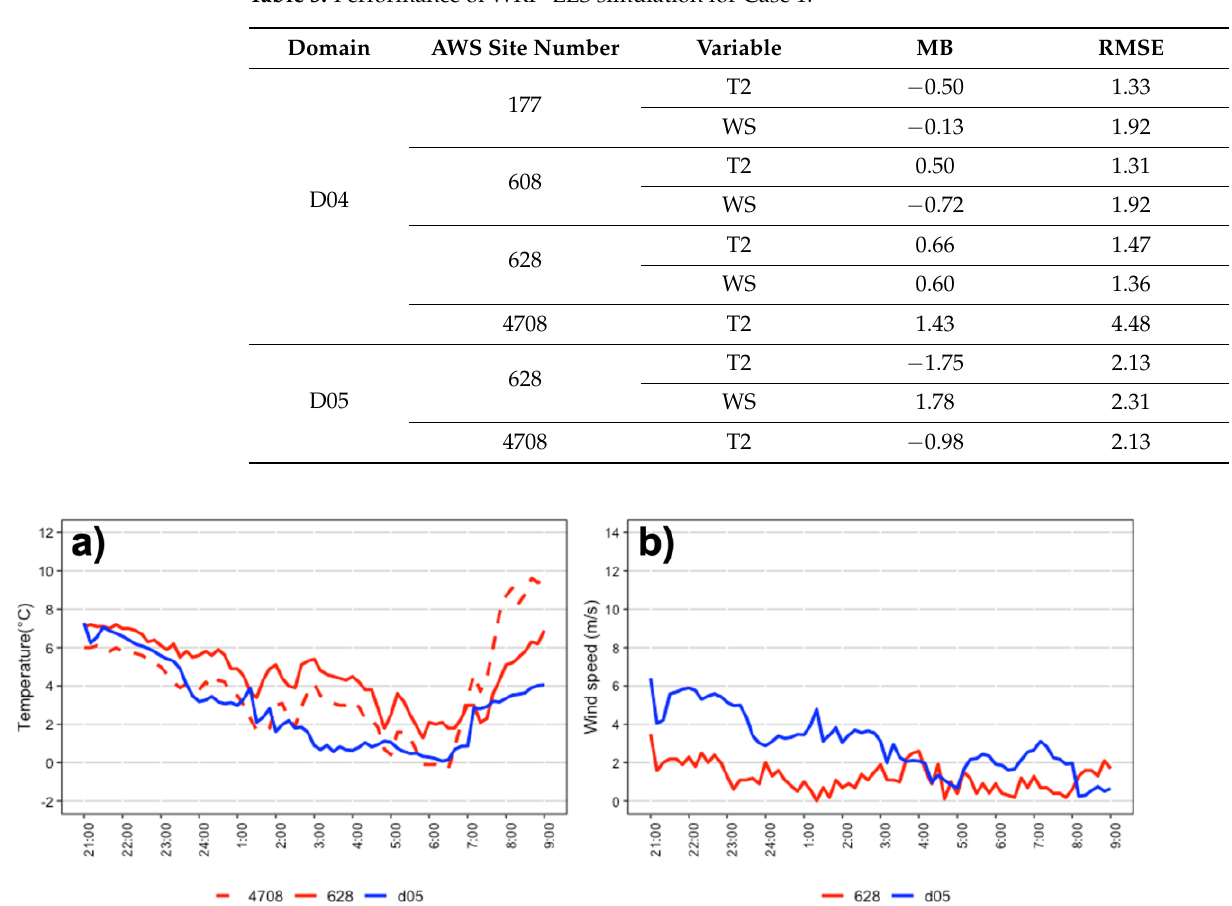
Table 3. Performance of WRF–LES simulation for Case 1.